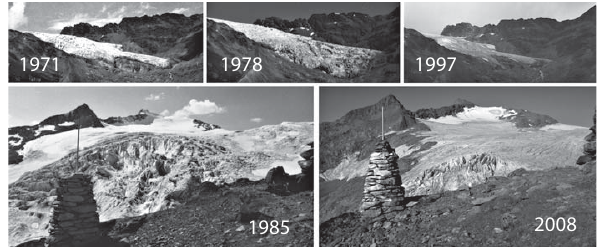
Fig. 8. The advance and retreat of the tongue of KWF in 1971, 1978 and 1995 with resulting changes in the upper part in 1985 and after slowing down in